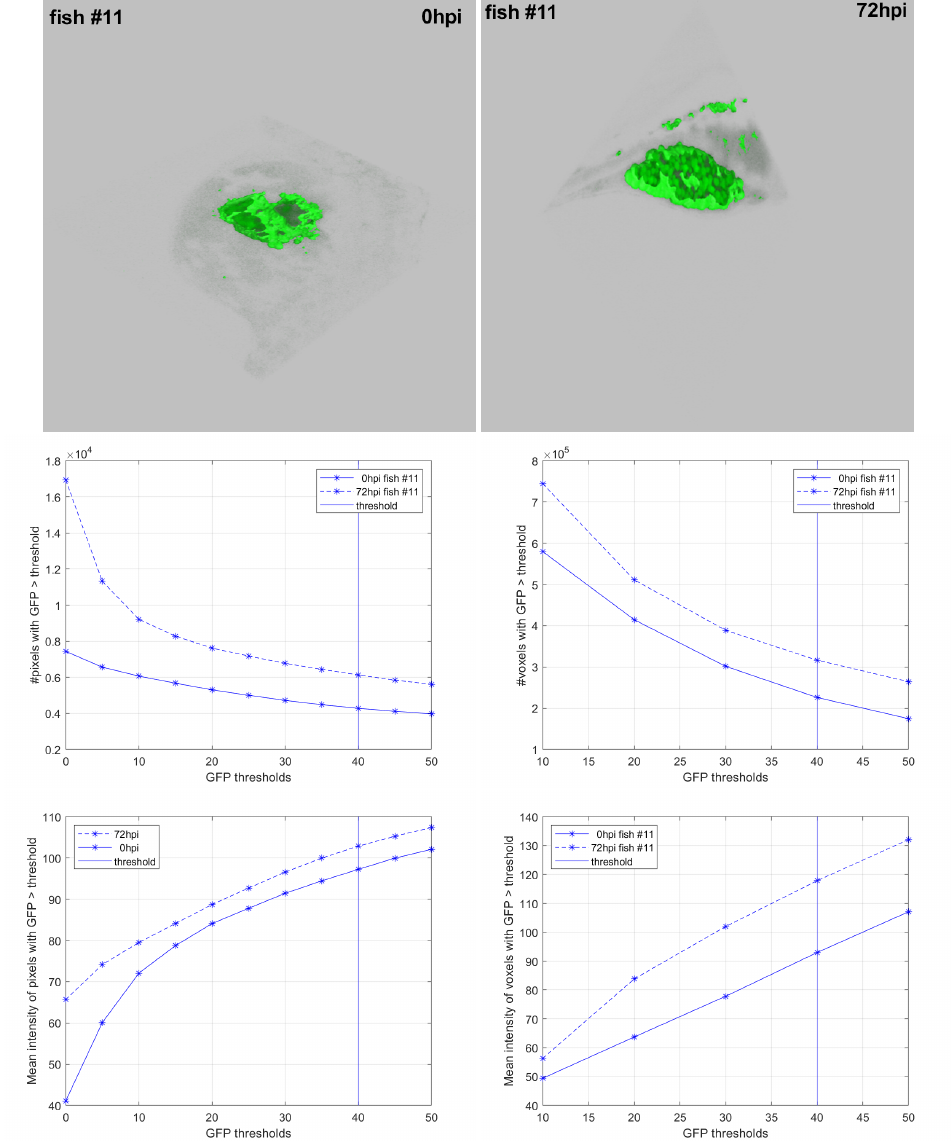
Figure 4. Comparison of 2D and 3D analyses for fish #11. First row: 2D analysis with ZFTool. Second row: 3D analysis with BioimageXD. Third row: # pixels evolution and # voxels evolution. Fourth row: GFP intensity evolution for pixels ( left ) and voxels ( right